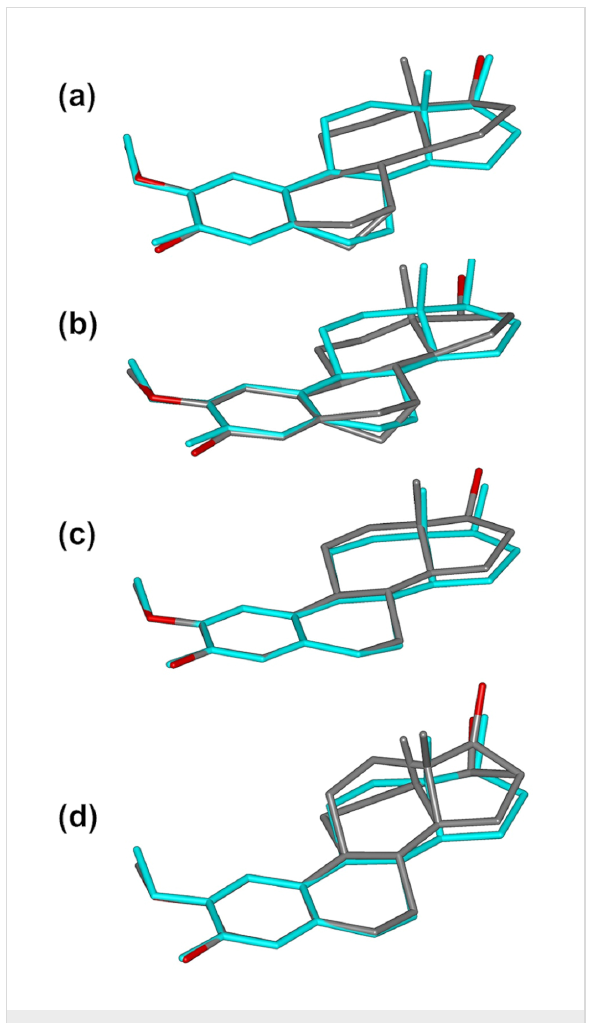
Figure 6: Overlay of the steroid nucleus of 2ME (blue) in its own crystal with the refined models (grey) of the four molecules of 2ME in the complex units A (a), B (b), C (c), D (d) of TRIMEB·2ME.